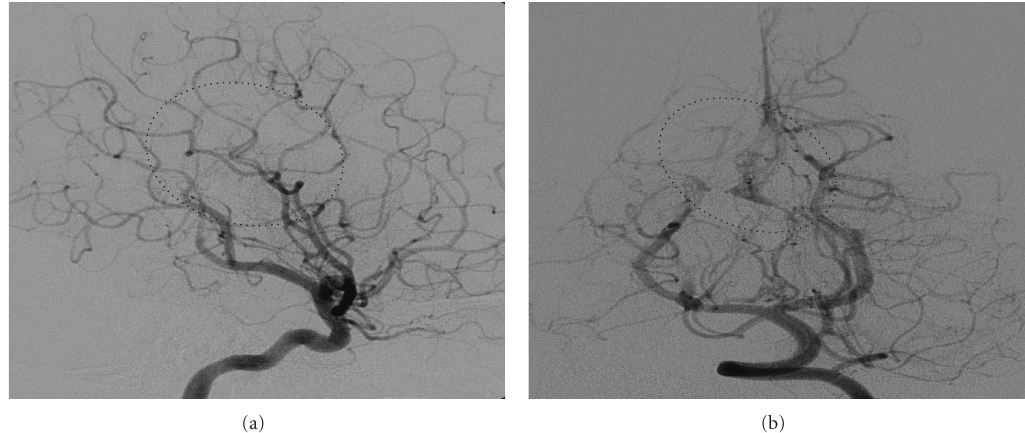
Figure 9: Digital subtraction angiography after second endovascular embolization. (a) Internal carotid artery, a pathological drainage cannot be longer represented (circle). (b) Vertebral artery, small residuum without relevant filling of the Vein of Galen (circle).